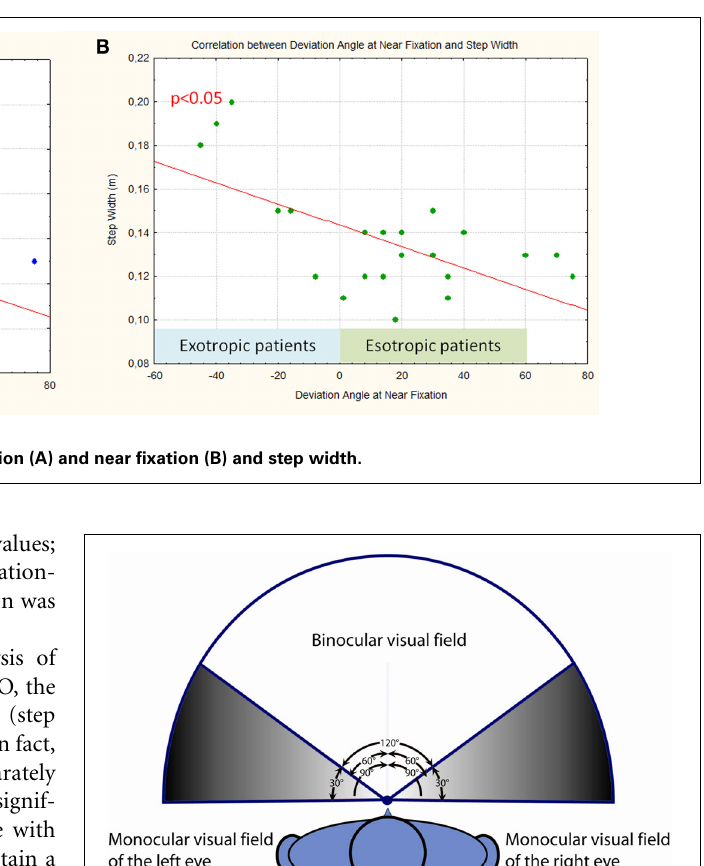
FIGURE 7 | Description of the normal binocular visual field and monocular visual field of the right and left